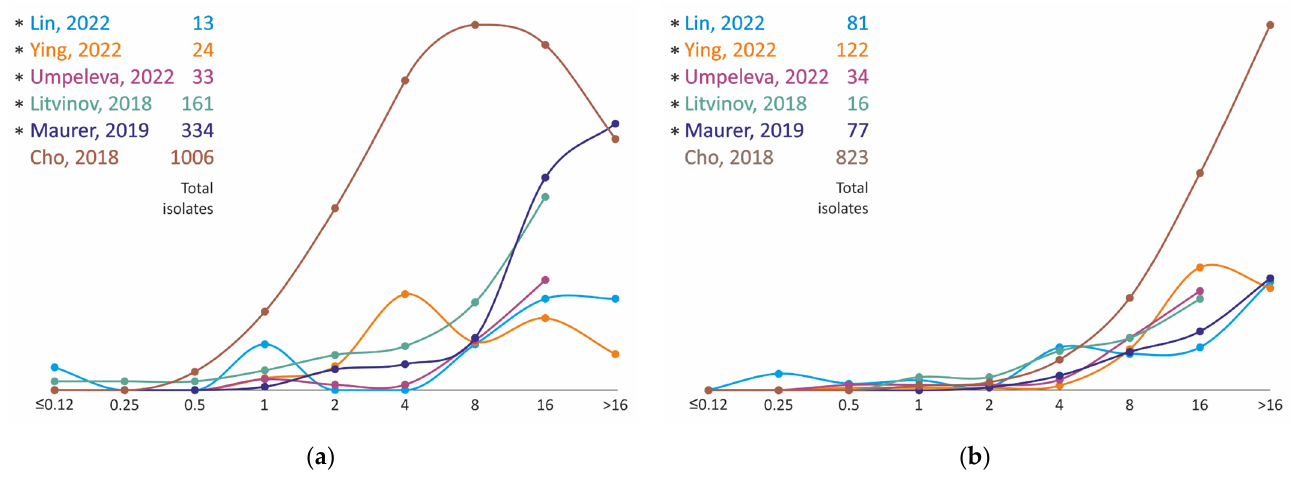
Figure 5. Ciprofloxacin MIC distribution for clinical isolates of M. avium ( a ) and M. intracellulare ( b ). * MIC obtained using Sensititre SLOMYCO plates.